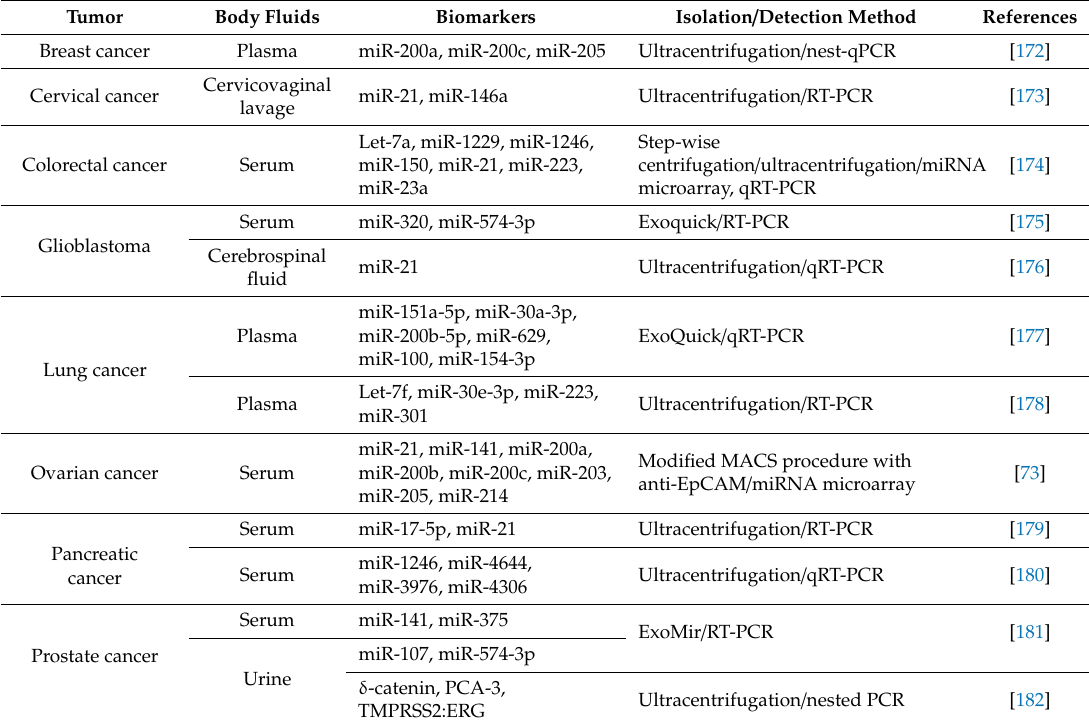
Table 4. EEVs miRNAs in